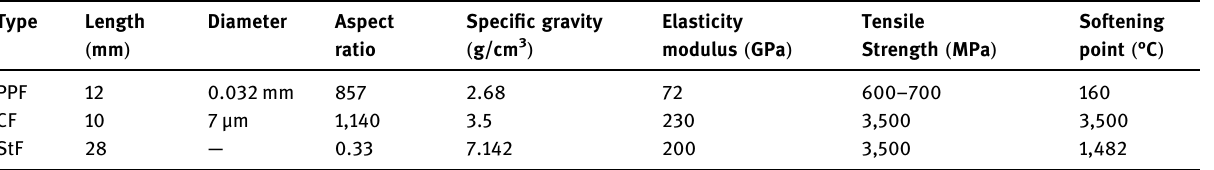
Table 4: Properties of di ff erent types of fi bers Type